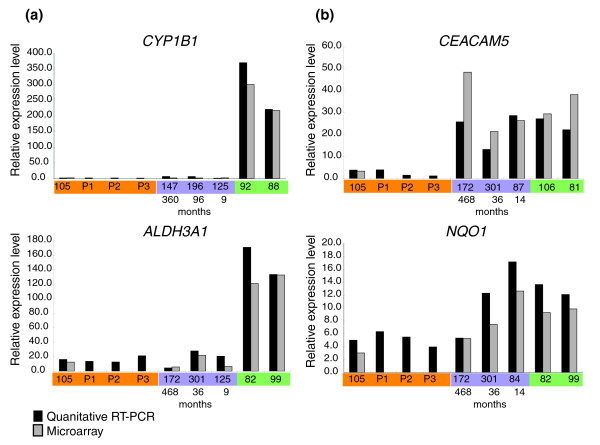
Quantitative real time PCR results for select genes across never, former, and current smokers. For each graph sample identifiers for never (orange), former (purple), and current (green) smokers are listed along the x-axis. The sample identifications P1, P2, and P3 refer to three samples collected prospectively from never smokers that do not have corresponding microarrays. The months since smoking cessation are listed below each former smoker. The relative expression level on the y-axis is the ratio of the expression level of a particular sample versus that of a dummy reference sample. (a) Plots of two rapidly reversible genes, CYP1B1 and ALDH3A1. (b) Plots of two irreversible genes, CEACAM5 and NQO1.